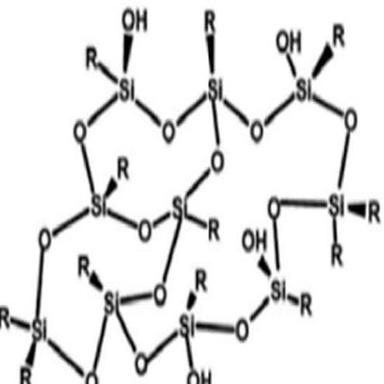
Heat flow generated by a) CEMI-based mortars and b) CEMIII/A-based mortars.